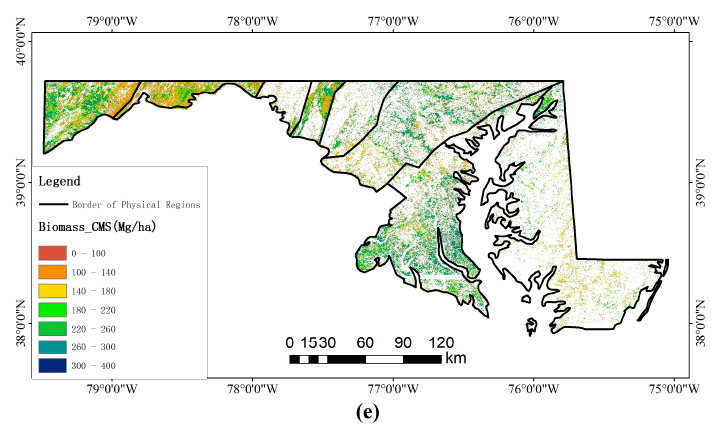
Figure 8. The distribution of forest aboveground biomass in Maryland. ( a ) Forest aboveground biomass estimated by the PCA power model; ( b ) Forest aboveground biomass estimated by the BP-ANN model; ( c ) Forest aboveground biomass estimated by the SVR model; ( d ) Forest aboveground biomass estimated by the RF model; and, ( e ) Forest aboveground biomass estimated by the CMS.